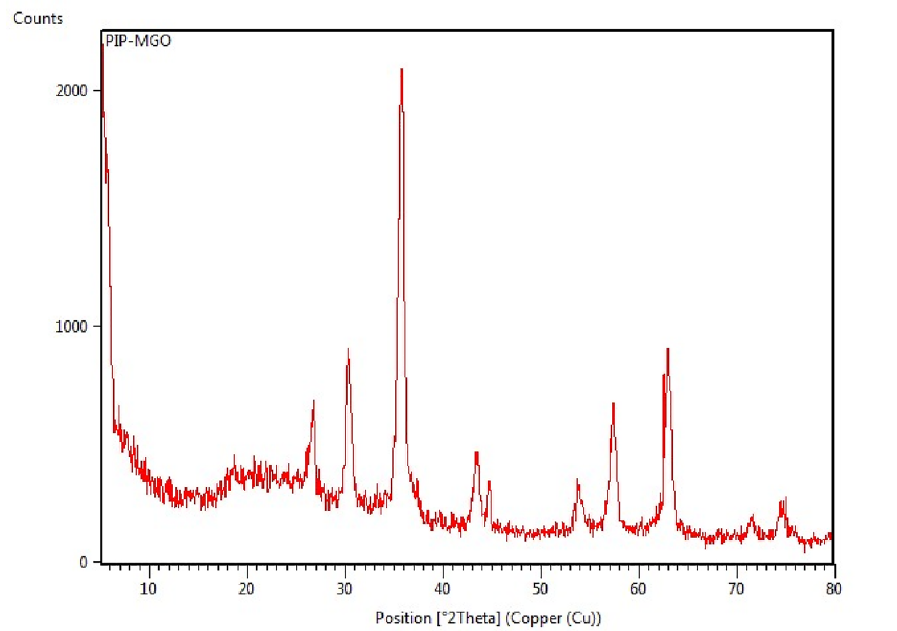
Figure 4. XRD pattern of Pip@MGO